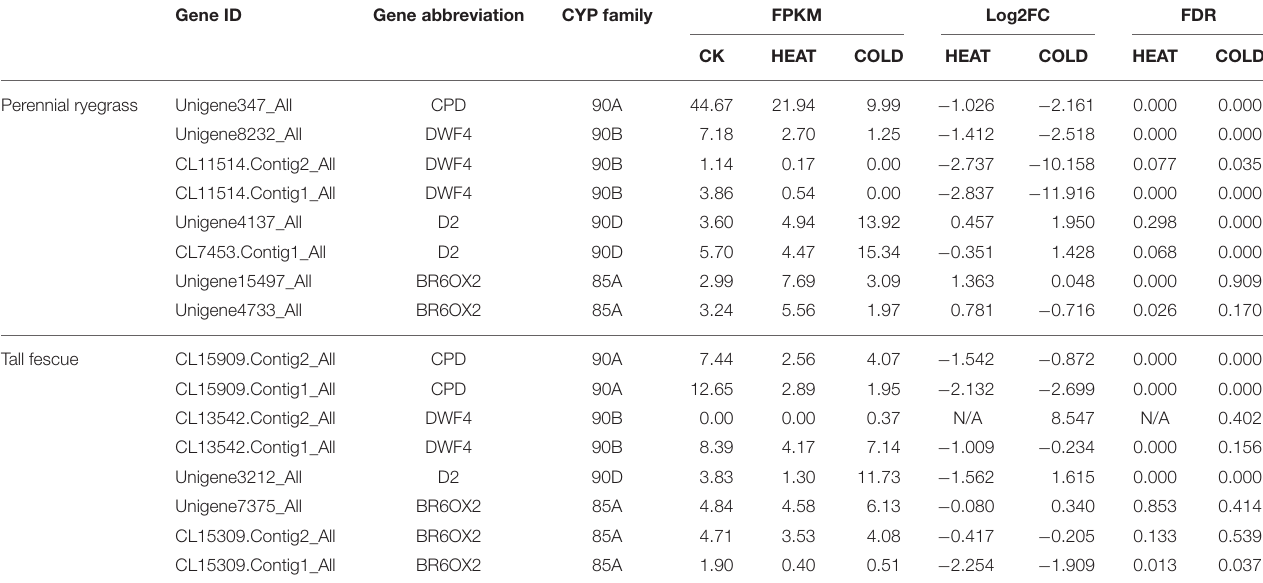
TABLE 2 | Expression of P450 transcripts involved in brassinosteroid